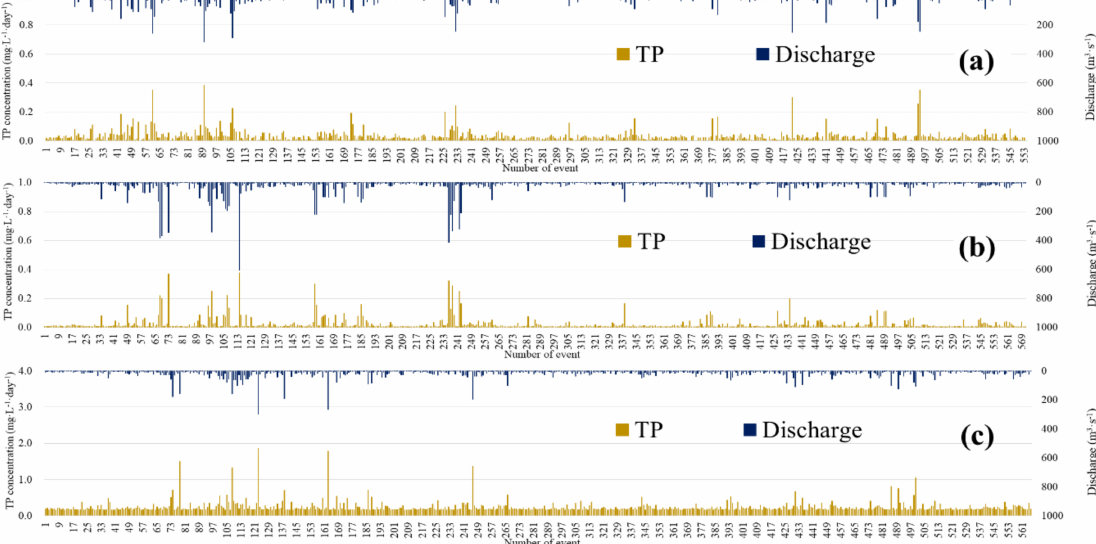
Figure 4. Variations in the discharge and TP concentration according to the date of the rainfall event: ( a ) JJ watershed; ( b ) HC watershed; ( c ) BH